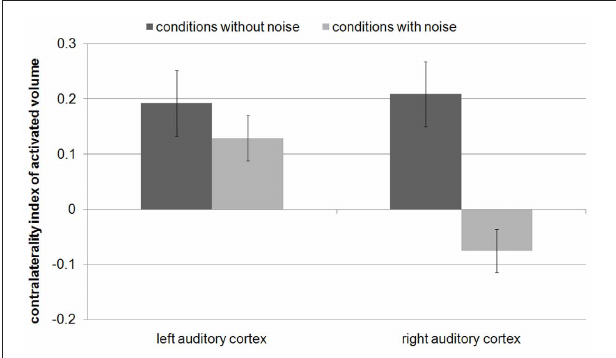
FIGURE 5 | Contralaterality index of the activated volume of our previous study (Behne et al., 2005), in which the subjects had to categorize individual tones according to their FM direction. In contrast to the present study, the contralaterality index significantly decreased from the condition without noise to the condition with noise only in the right auditory cortex ( p < 0 .